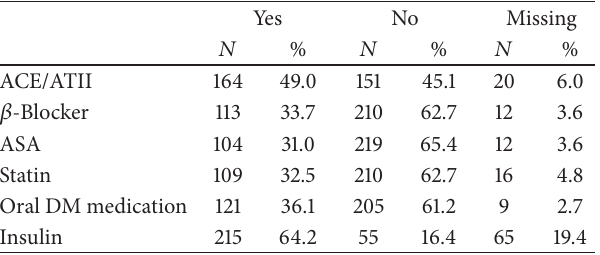
Table 3: Percentages of diabetic patients using lipid lowering, antihypertensive, oral diabetes medication, insulin, or ASA. Yes No